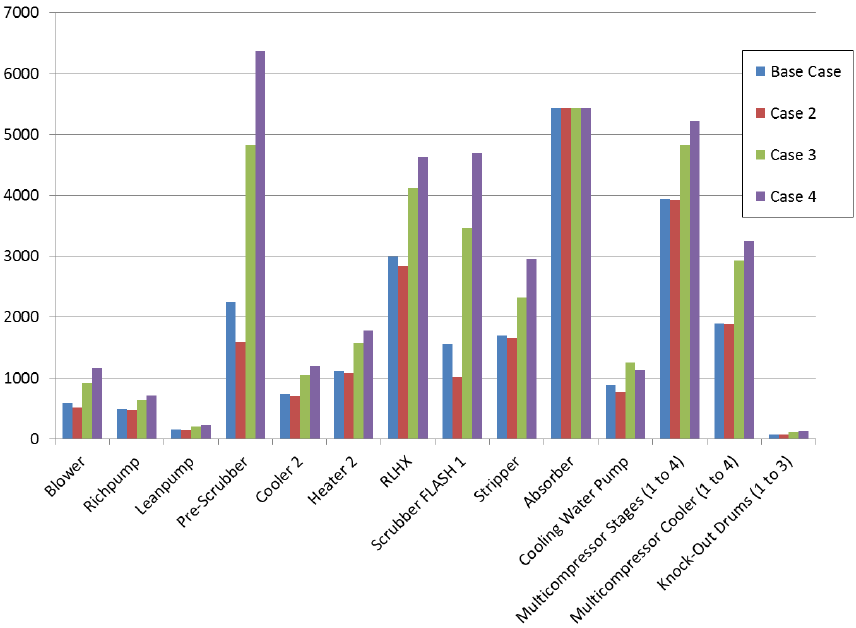
Figure 2. Purchased equipment costs for carbon capture in cement